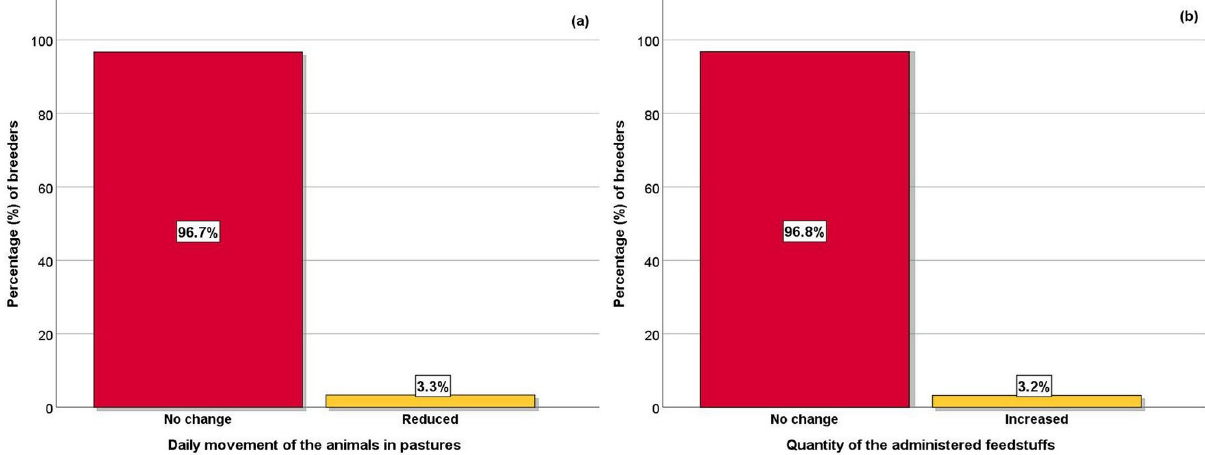
Figure 2. Effect of COVID-19 restrictive measures on (a) small ruminant daily movements in pastures and (b) the quantity of the adminis- tered feedstuffs.